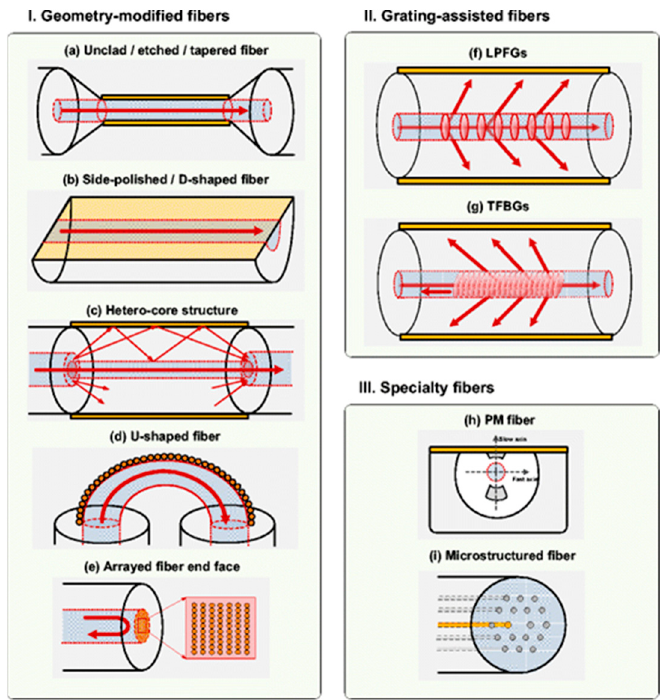
Figure 2. An overview of different structure-modified optical fibers. ( I ) Geometry-modified optical fibers: ( a ) Unclad, etched, ( b ) side-polished, D-shaped fibers, ( c ) hetero-core structures, ( d ) U-shaped fibers, and ( e ) arrayed fiber end face. ( II ) Grating-assisted fibers. ( III ) Specialty fibers. Reproduced with permission from [20].